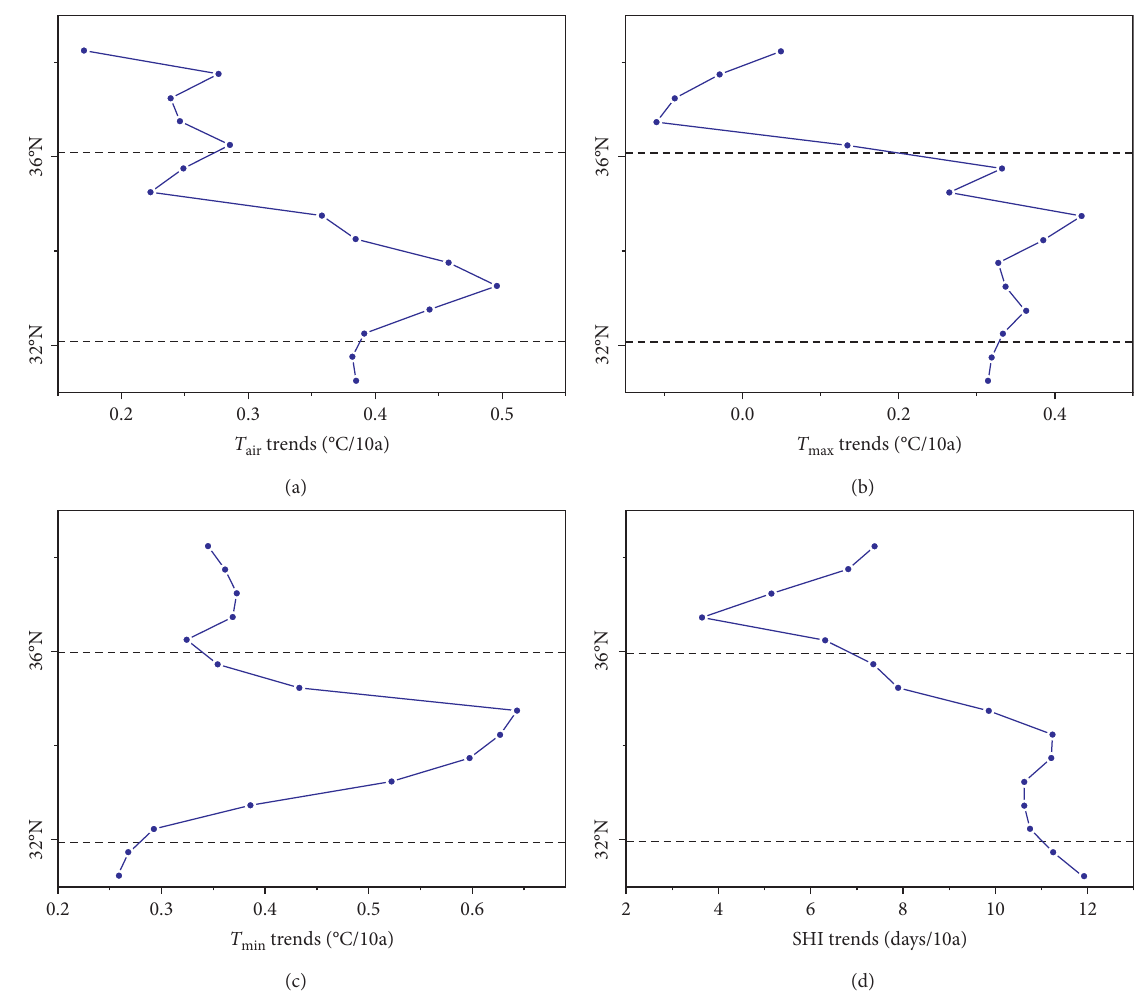
Figure 4: The trends of the spatial averages of (a) T